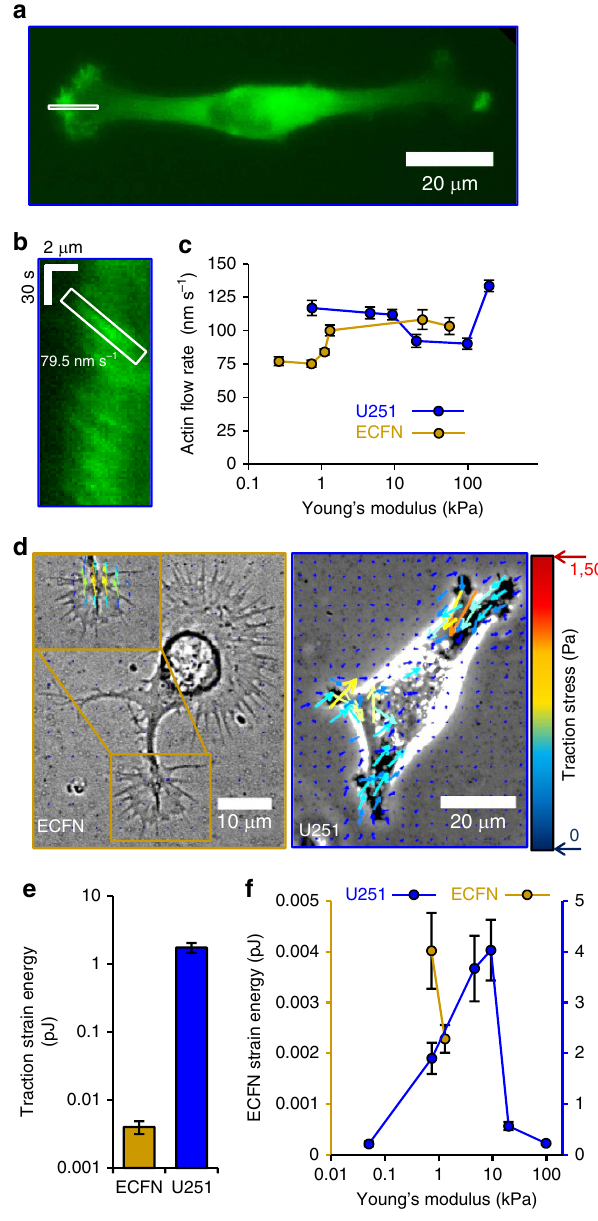
Figure 3 | Actin retrograde flow and traction strain energy of U251 glioma cells versus ECFNs. ( a ) Representative fluorescent image of an EGFP-actin U251 glioma cell on a 100kPa polyacrylamide gel. The boxed region represents an area selected for an actin flow kymograph. ( b ) Actin flow kymograph for a U251 glioma cell on a 100kPa polyacrylamide gel. Horizontal bar is 2 m m. Vertical bar is 30s. ( c ) Embryonic chick forebrain neuron (ECFN; data taken from Chan and Odde 7 ) and U251 glioma cell actin retrograde flow versus substrate stiffness. U251 actin flow has a minimum between 9 and 200kPa ( P ¼ 0.004). ( d ) Representative phase-contrast images with traction field overlays of an ECFN and a U251 glioma cell on 700Pa polyacrylamide gels. Traction vectors were thinned fourfold for ease of visualization. (Inset) Region of ECFN with traction vectors expanded by 60-fold. ( e ) Mean strain energy of ECFNs and U251 glioma cells on 700kPa polyacrylamide gels. U251 strain energy is significantly higher than for ECFNs ( P ¼ 10–24). ( f ) U251 stain energy has a maximum between 4.6 and 20kPa ( P ¼ 0.0002). ECFN data were adapted from Chan and Odde 7 . All error bars are